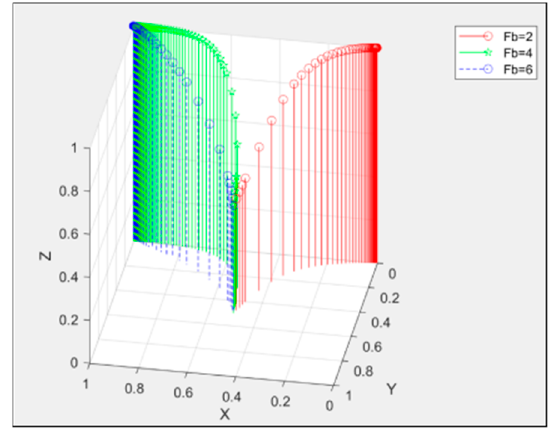
Figure 9. The influence of punishment FC on the strategy choice of each party.